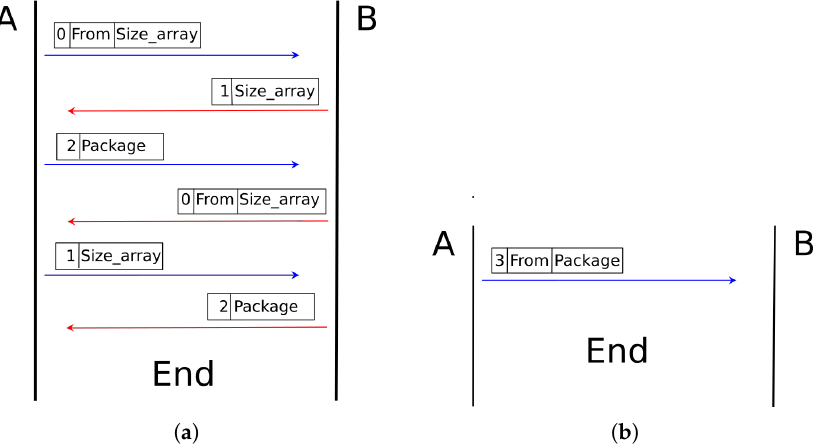
Figure 6. Wireless data transmission analysis. ( a )data transfer through an information request , ( b )data transfer through an immediately